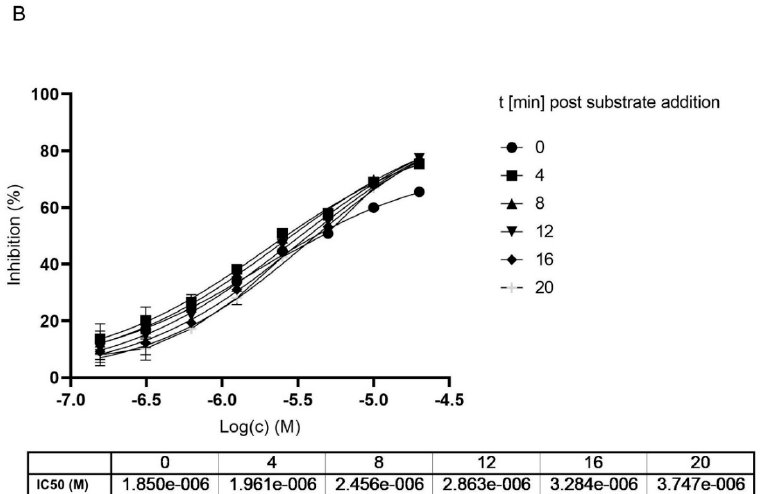
Figure 5. Dose and time dependent inhibition of Mpro using MG-132. ( A ) without preincubation of Mpro with MG-132. ( B ) after 1 h preincubation of Mpro with MG-132. Dose response curves were measured at different time points after substrate addition.